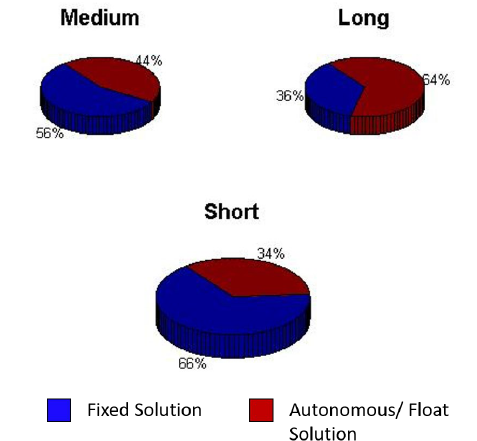
Figure 3. Percentage of AR for short, medium and ling baseline